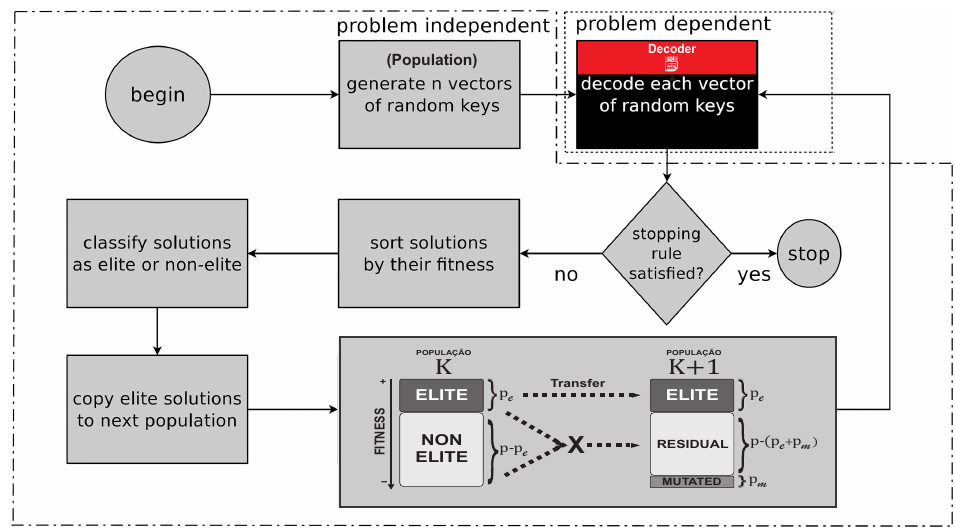
Figure 8. A flowchart of BRKGA and